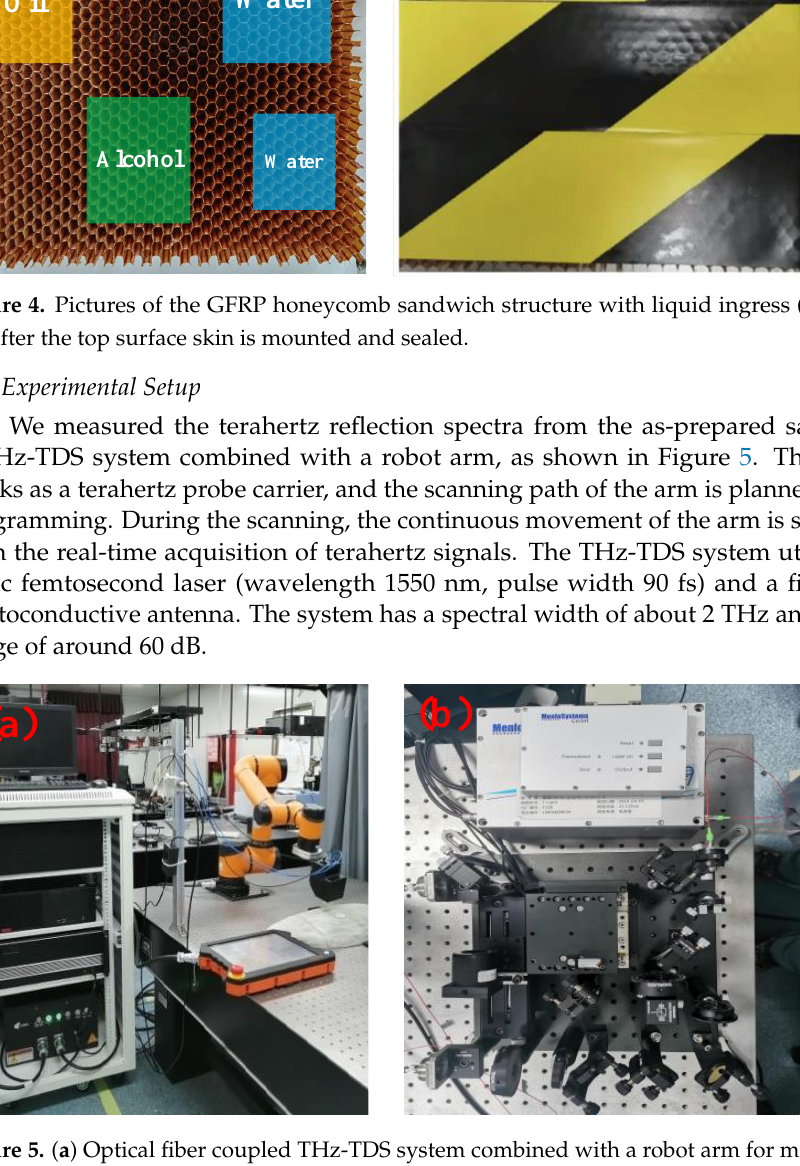
Figure 5. ( a ) Optical fiber coupled THz-TDS system combined with a robot arm for multi-degree-of- freedom manipulator scanning. ( b ) Zoom of the THz-TDS